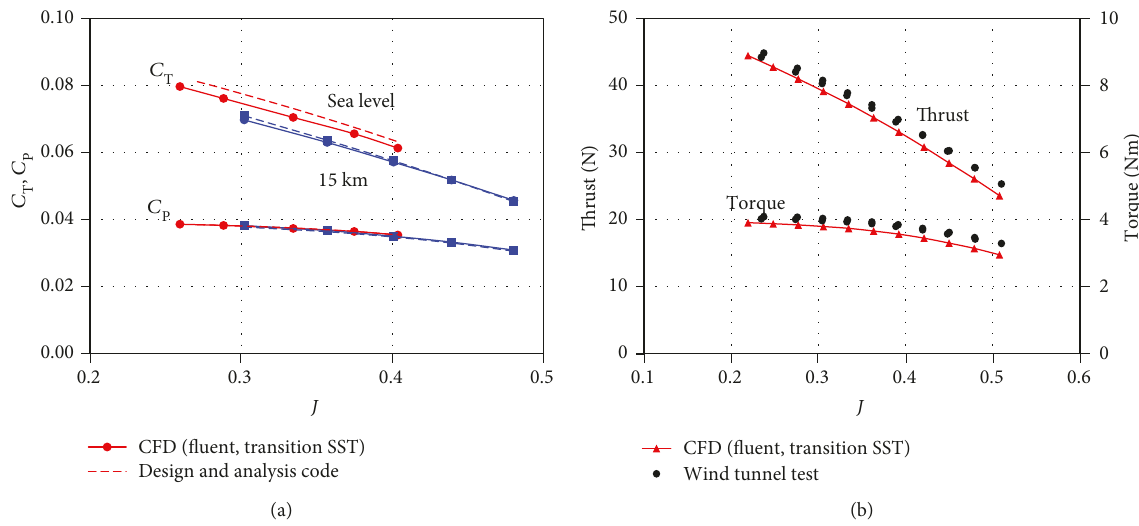
Figure 19: Comparison of CFD results with (a) design code and (b) wind tunnel test.